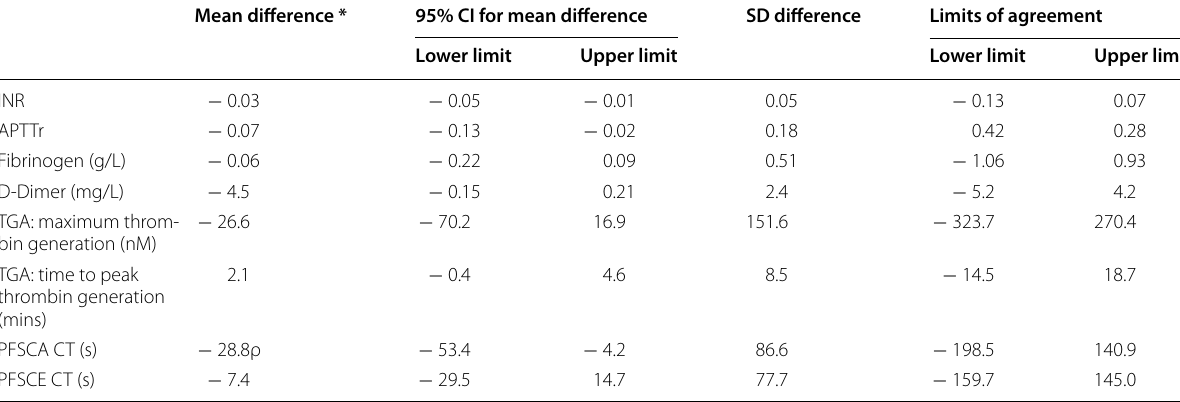
Table 4 Agreement between systemic and circuit